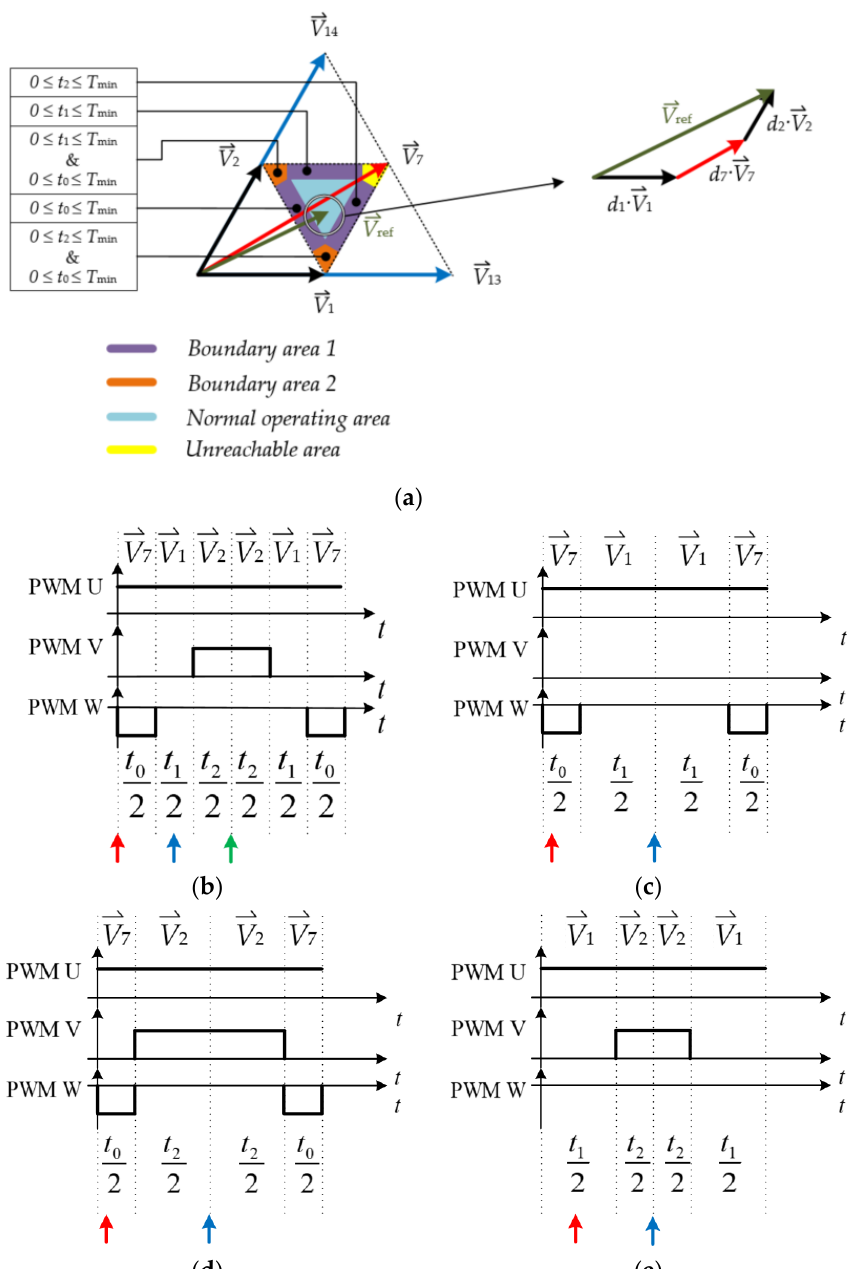
Figure 10. ( a ) Vector diagram for Sector 1 and Region 2 with marked problematic areas for single- shunt measurement; ( b ) SVM pattern for Sector 1 and Region 2 inside the normal operating area; ( c ) SVM pattern while t 2 = 0 s; ( d ) SVM pattern while t 1 = 0 s; ( e ) SVM pattern while t 0 = 0 s.